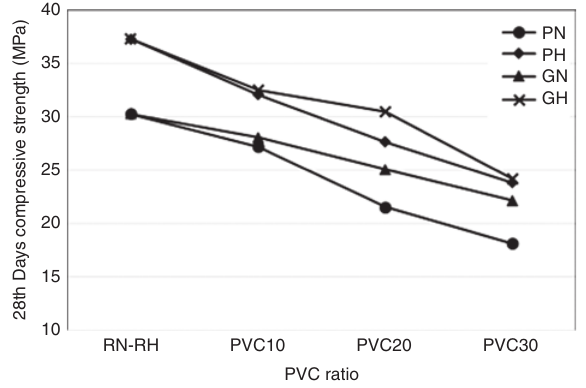
Figure 10 Permeable pore space of polyvinyl chloride-containing concretes. Figure 12 Twenty-eighth day compressive strength.